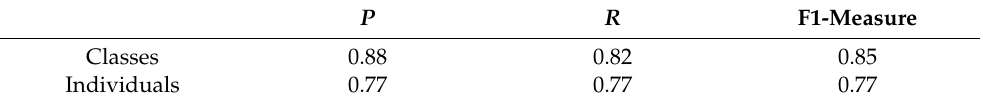
Table 1. Precision, recall, and F1-measure of the automatic matching